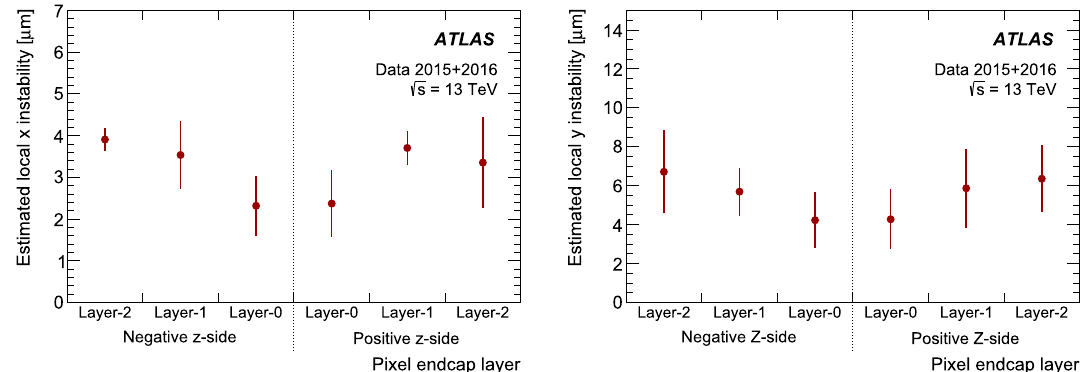
Fig. 16 Estimated σ time x , y as a function of module η index for Pixel endcap layers. The vertical bar on each marker represents the standard deviation of the estimated value over modules of the same